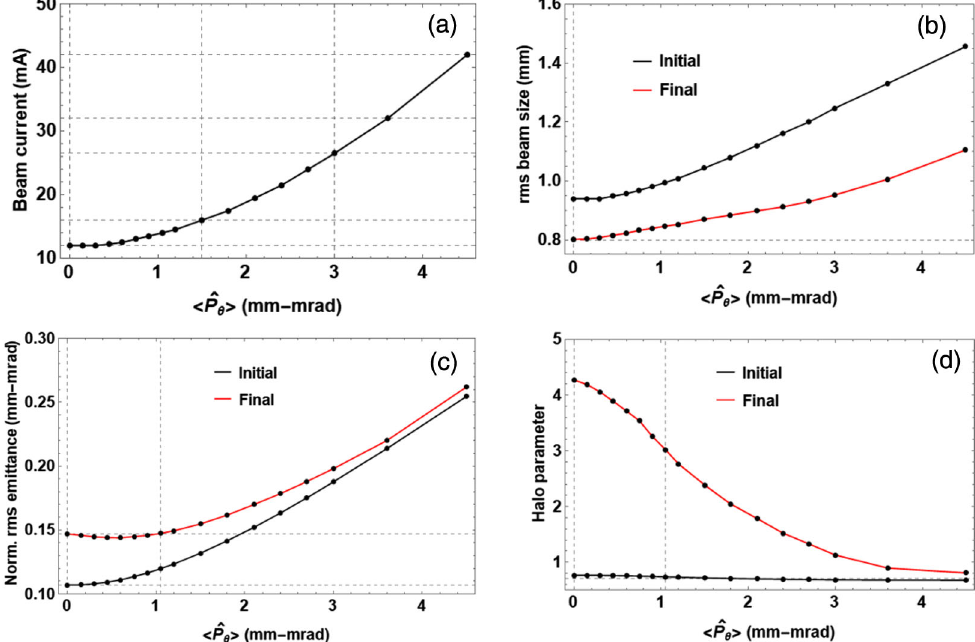
ˆ P FIG. 12. A parametric study with various values of h θ i . (a) Beam current (mA), (b) rms beam size (mm), (c) normalized rms emittance (mm · mrad), and (d) halo parameter with acceleration under the solenoid focusing lattice. Here, σ ⊥ 0 decreases from 120° to 90° as the beams are accelerated, and σ ⊥ ∼ 76 ° remains constant along the linac. For the same tune depression space, the beam ˆ P current could be increased as h θ i increases. For the spinning beams, the initial emittance increases from canonical angular momentum, but the relative emittance growth [i.e., the ratio of final emittance to initial emittance in (c)] is substantially reduced. The mitigation effect of the spinning beam on fourth-order particle resonance is evidently observed in terms of the suppression of the halo parameters [red line in